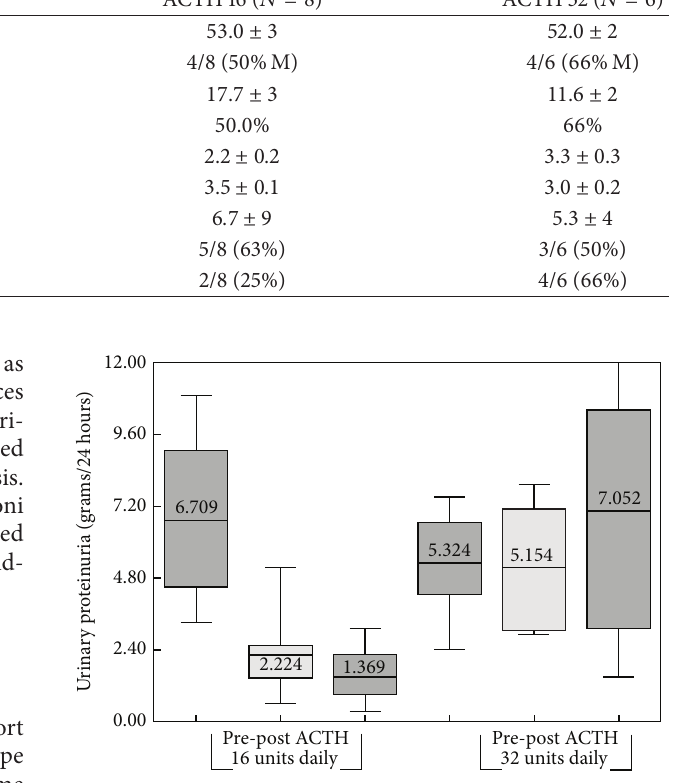
Figure 3: Whisker box plots of 24-hour urinary protein (grams/24hrs) response for the 16- and 32-unit ACTH groups. A significant reduction in proteinuria is noted for the 16-unit dose at 6 months with a trend toward additional reduction in proteinuria 6 months after withdrawing ACTH. No effect is seen with the 32-unit ACTH